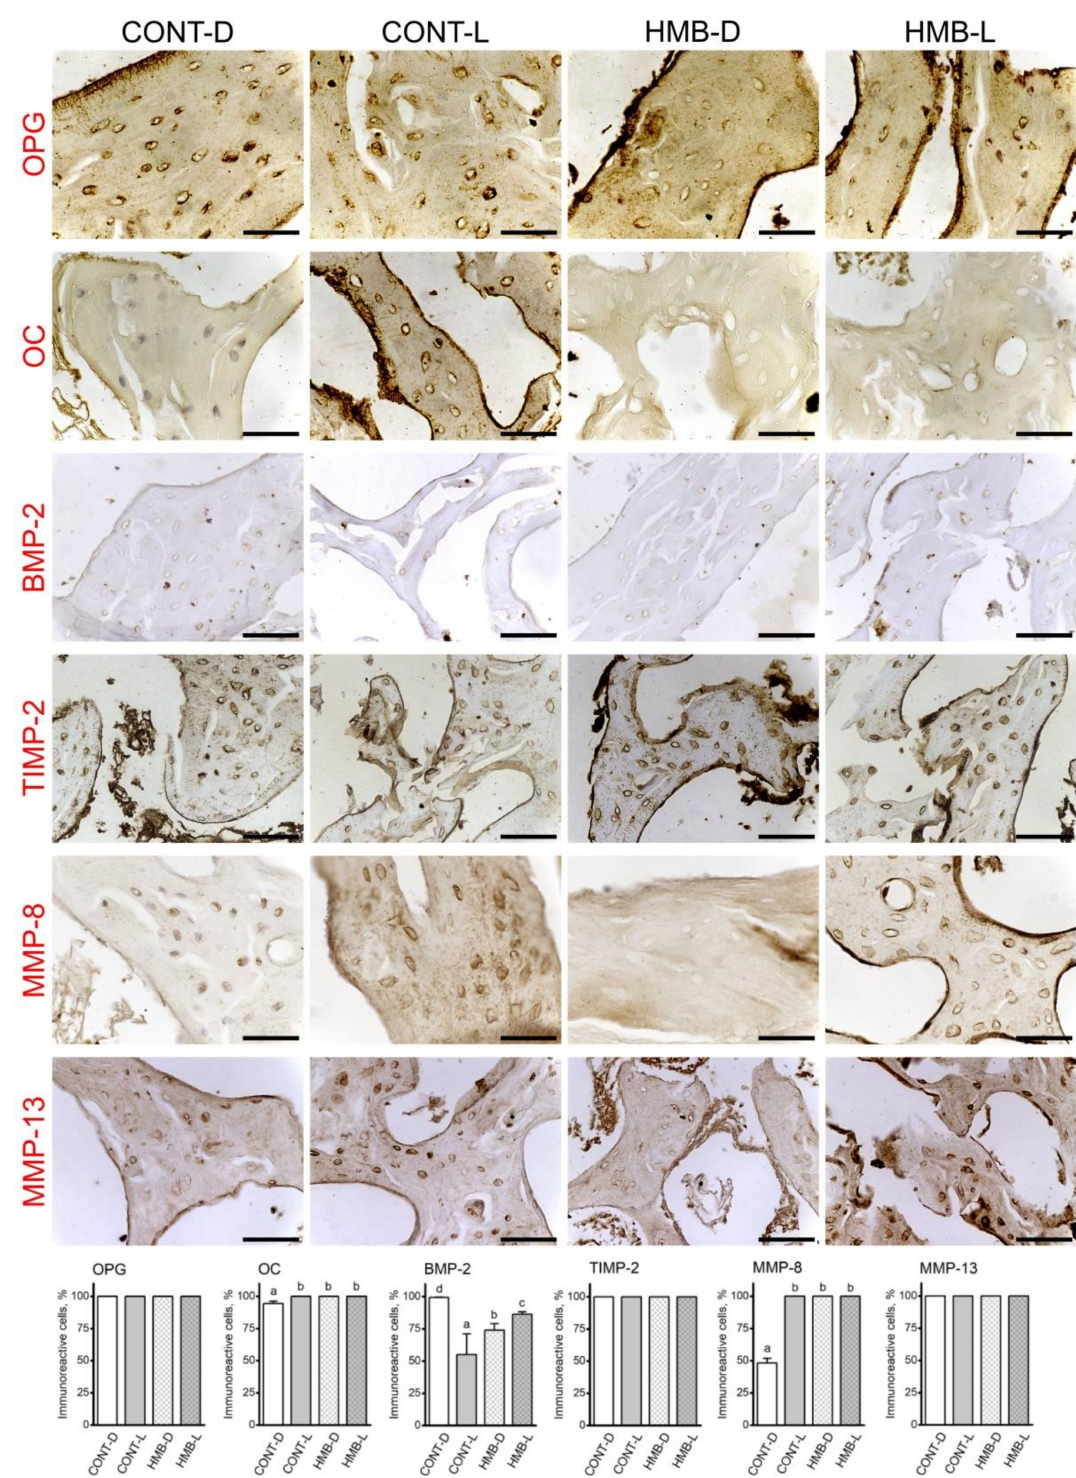
Figure 6. Representative images of the immunohistochemical reactions and the percent of immunoreactive cells for osteoprotegerin (OPG), osteocalcin (OC), bone morphogenetic protein 2 (BMP-2), tissue inhibitor of metalloproteinases 2 (TIMP-2), matrix metalloproteinase 8 (MMP-8) and matrix metalloproteinase 13 (MMP-13) in the trabecular bone of femora from pregnant female controls (not receiving HMB) at delivery (CONT-D) or after the lactation period (CONT-L) and from pregnant HMB females (receiving HMB at a dose of 0.02 g/kg b.w. during the middle trimester of pregnancy) at delivery (HMB-D) or after the lactation period (HMB-L). All the scale bars represent 40 µ m. Bar plots show the percentage of immunoreactive osteocytes in the trabecular bone in each